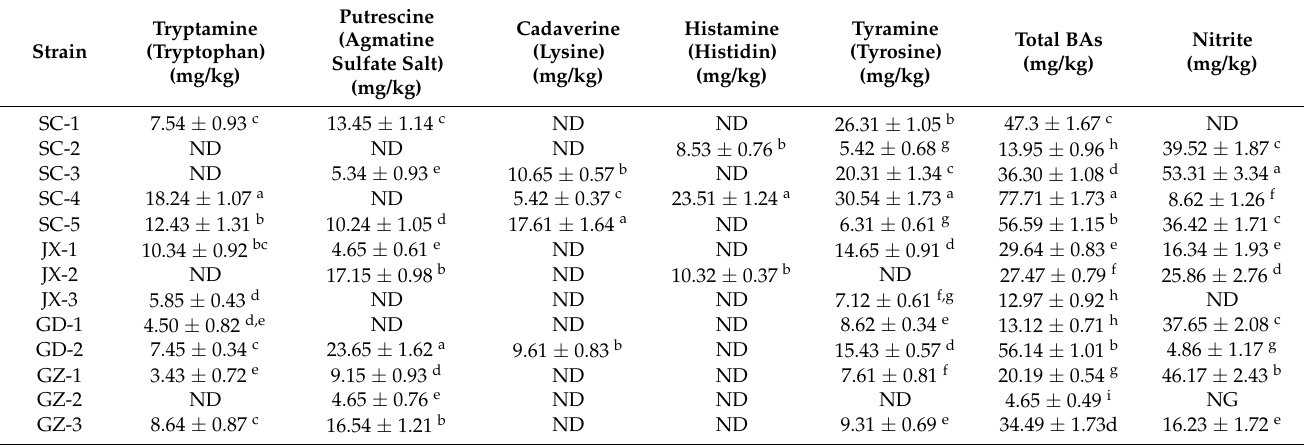
Table 5. The BA-producing abilities of the isolated strains with corresponding precursor. Different letters (a, b, c, etc.) indicate significantly different means at p <